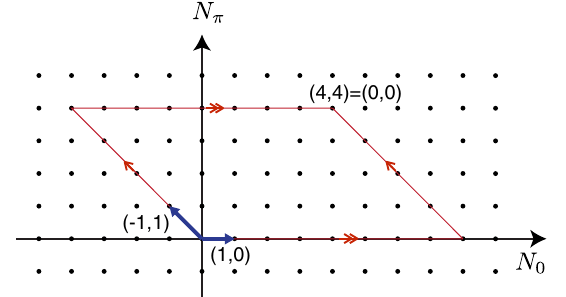
FIG. 3. Group structure of interacting Floquet SPT phases of spinless TR-invariant superconductors (class BDI). In the ab- sence of interactions, each point corresponds to a topological phase with N 0 MZMs and N π MPMs at the edge. With interactions, only points on a discrete torus (bounded red region, with arrows indicating periodic boundary conditions) correspond to distinct topological phases of the Z 8 × Z 4 classification. The blue vectors (1,0) and ð − 1 ; 1 Þ are generators of the subgroups Z 8 and Z 4 , respectively.